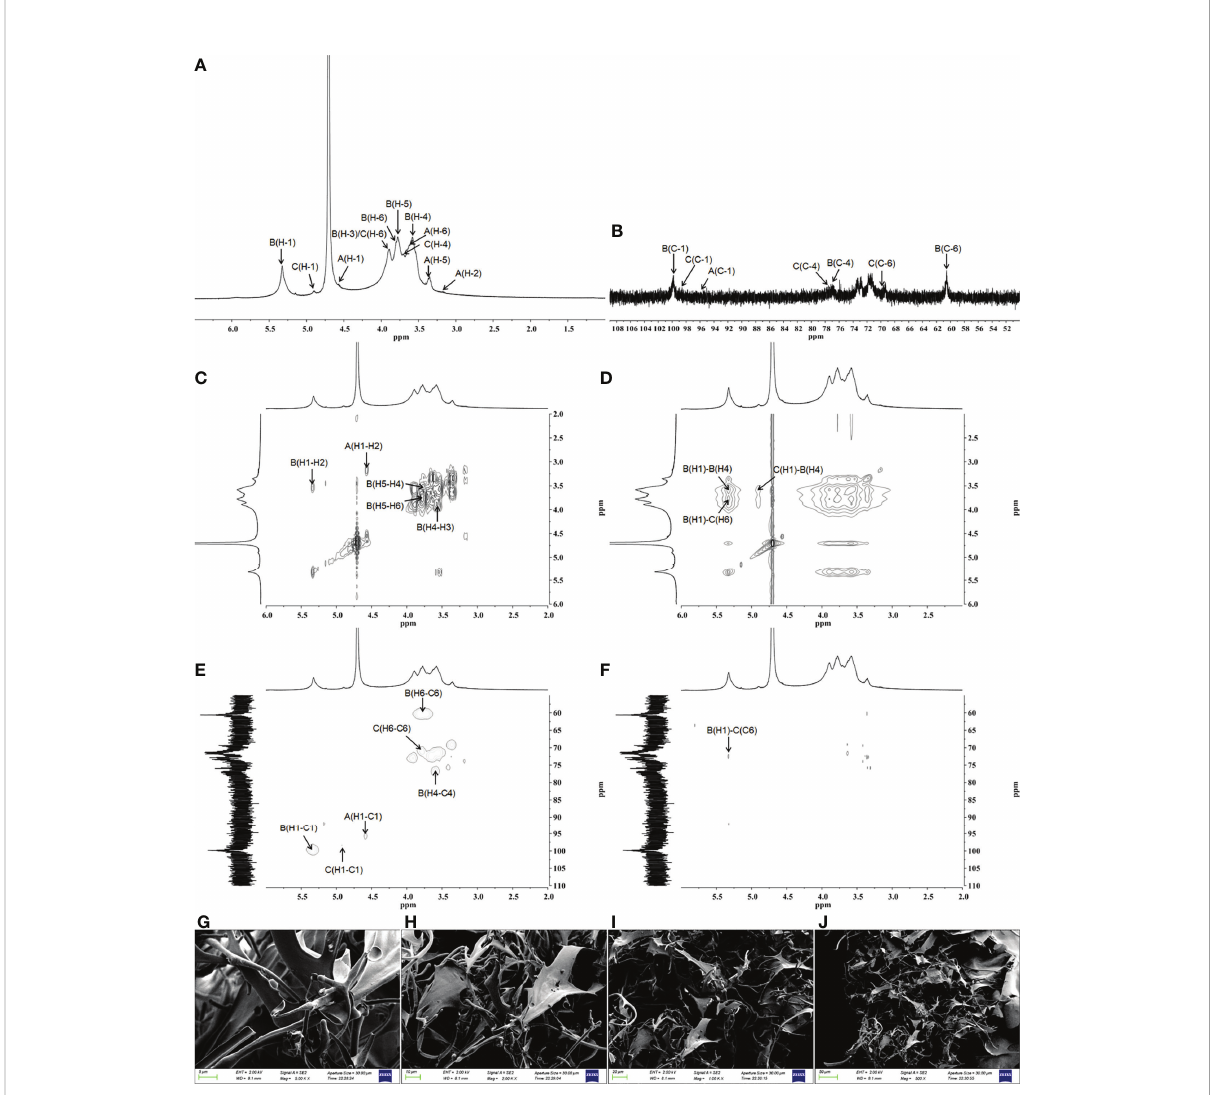
FIGURE 2 Structural characterization of GFPA via NMR and SEM. The structure of GFPA was analyzed by (A) 1 H-NMR, (B) 13 C-NMR, (C) COSY, (D) NOESY, (E) HSQC and (F) HMBC. The morphology of GFPA was evaluated by SEM at (G) 5,000×, scale bar: 5 m m; (H) 2,000×, scale bar: 10 m m; (I)